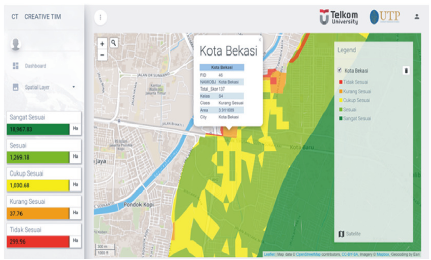
Figure 12: City location analysis process.